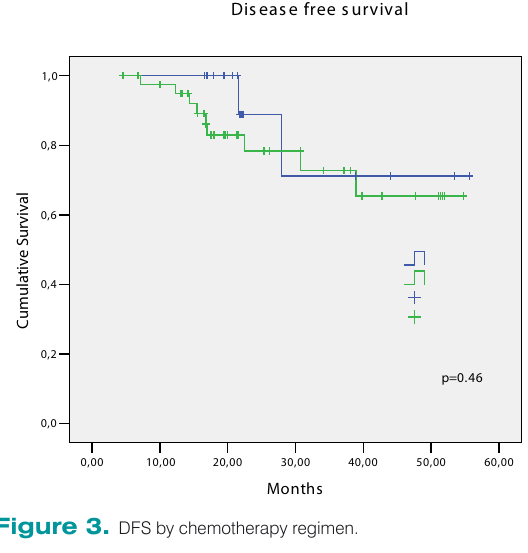
Figure 2. DFS by receptor